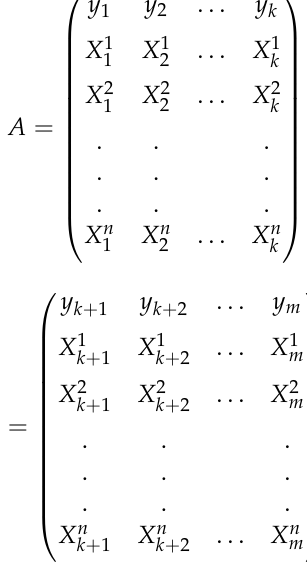
Estimate the accuracy